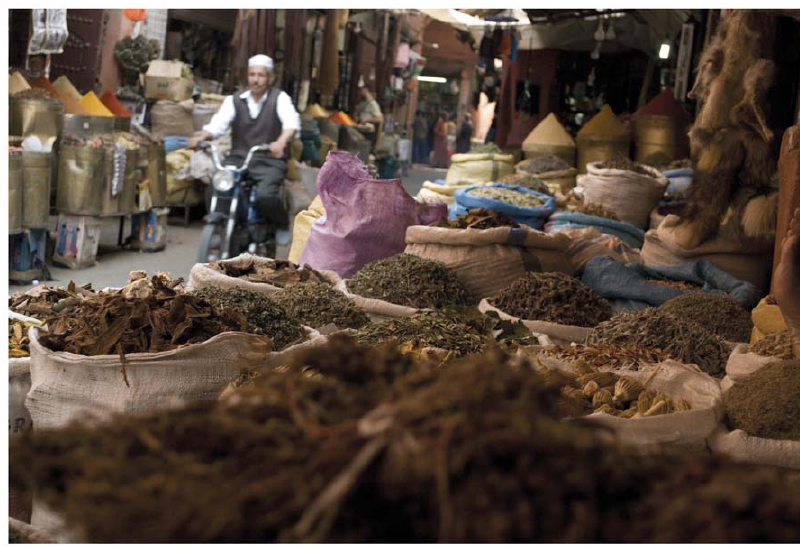
Figure 1. Typical herbalist shop in the medina of Marrakech.